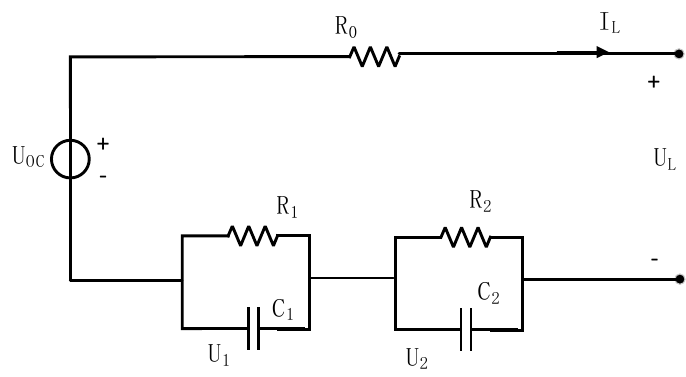
Figure 1. Schematic diagram of second-order resistor-capacitor (2RC) equivalent circuit model.